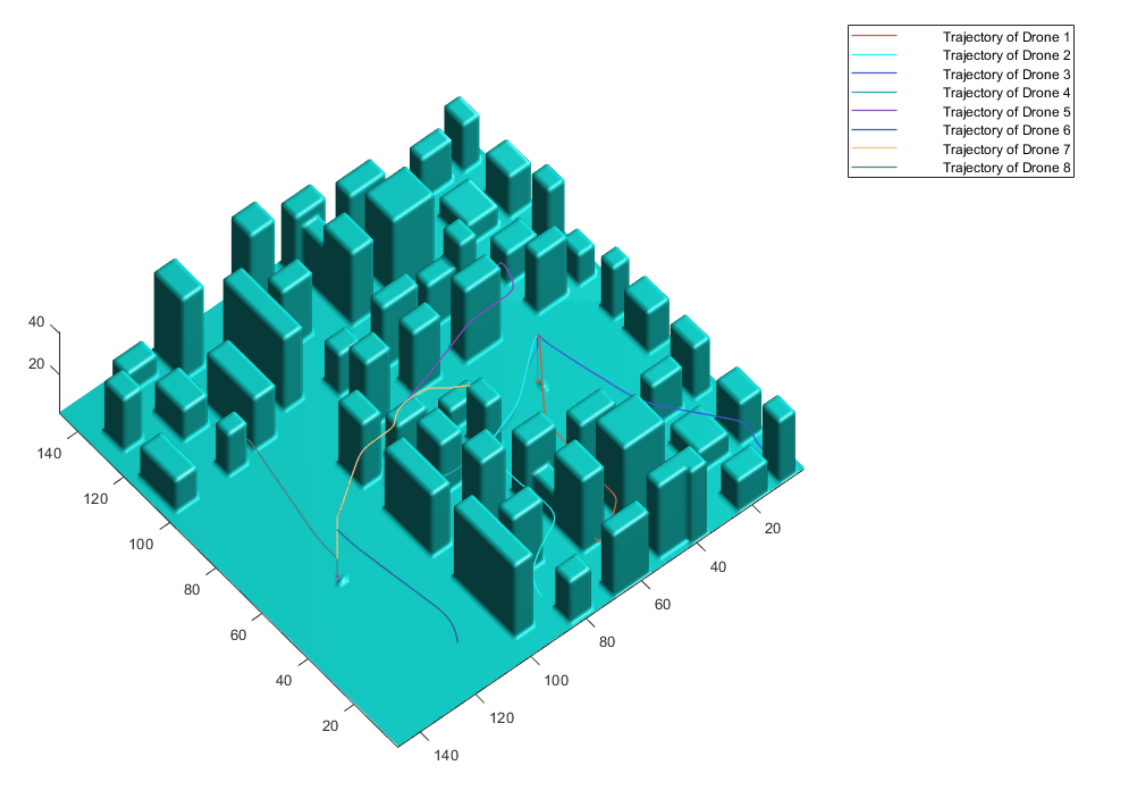
Figure 4. Representation of the trajectories calculated with FM2 on the simulated